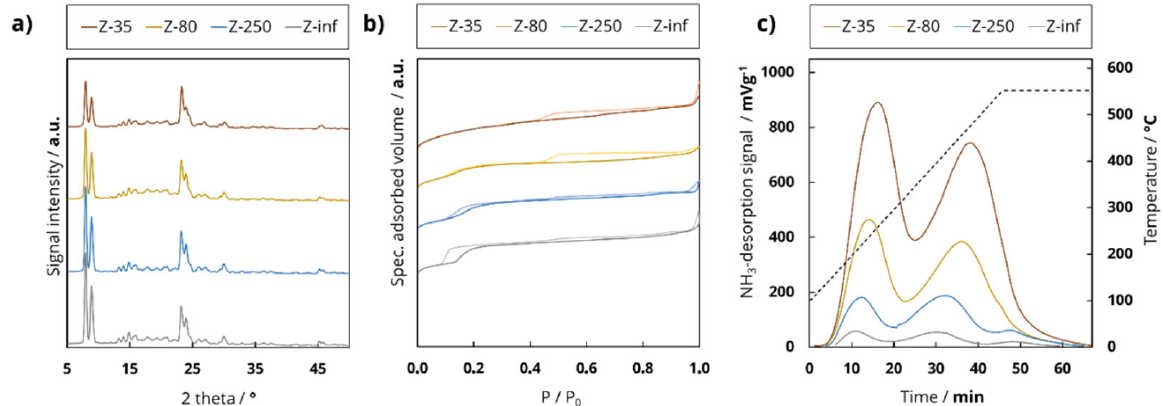
Figure 2. ( a ) Powder X-ray diffraction patterns, ( b ) N 2 physisorption isotherms, ( c ) temperature-programmed ammonia desorption (TPAD) profiles of the prepared H-ZSM-5 zeolite samples. Table 1. Textural and acidity properties of the prepared H-ZSM-5 zeolite samples.